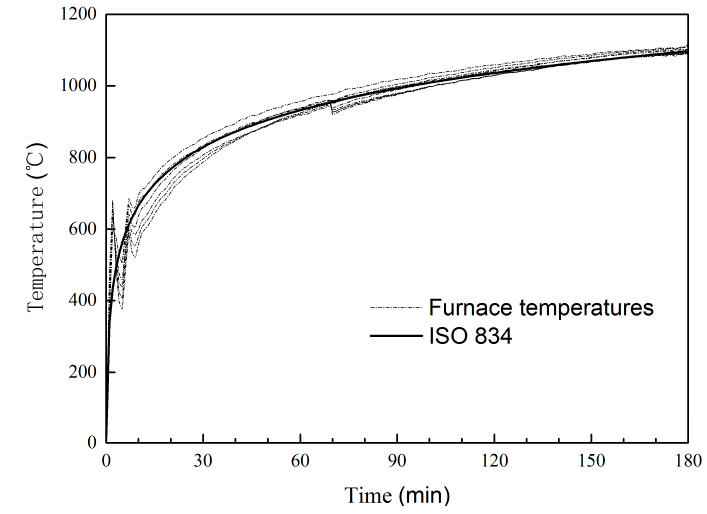
Figure 8. Furnace temperatures for HSS-C2.